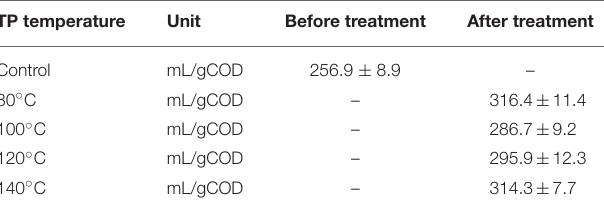
TABLE 5 | Specific methane yield before and after each